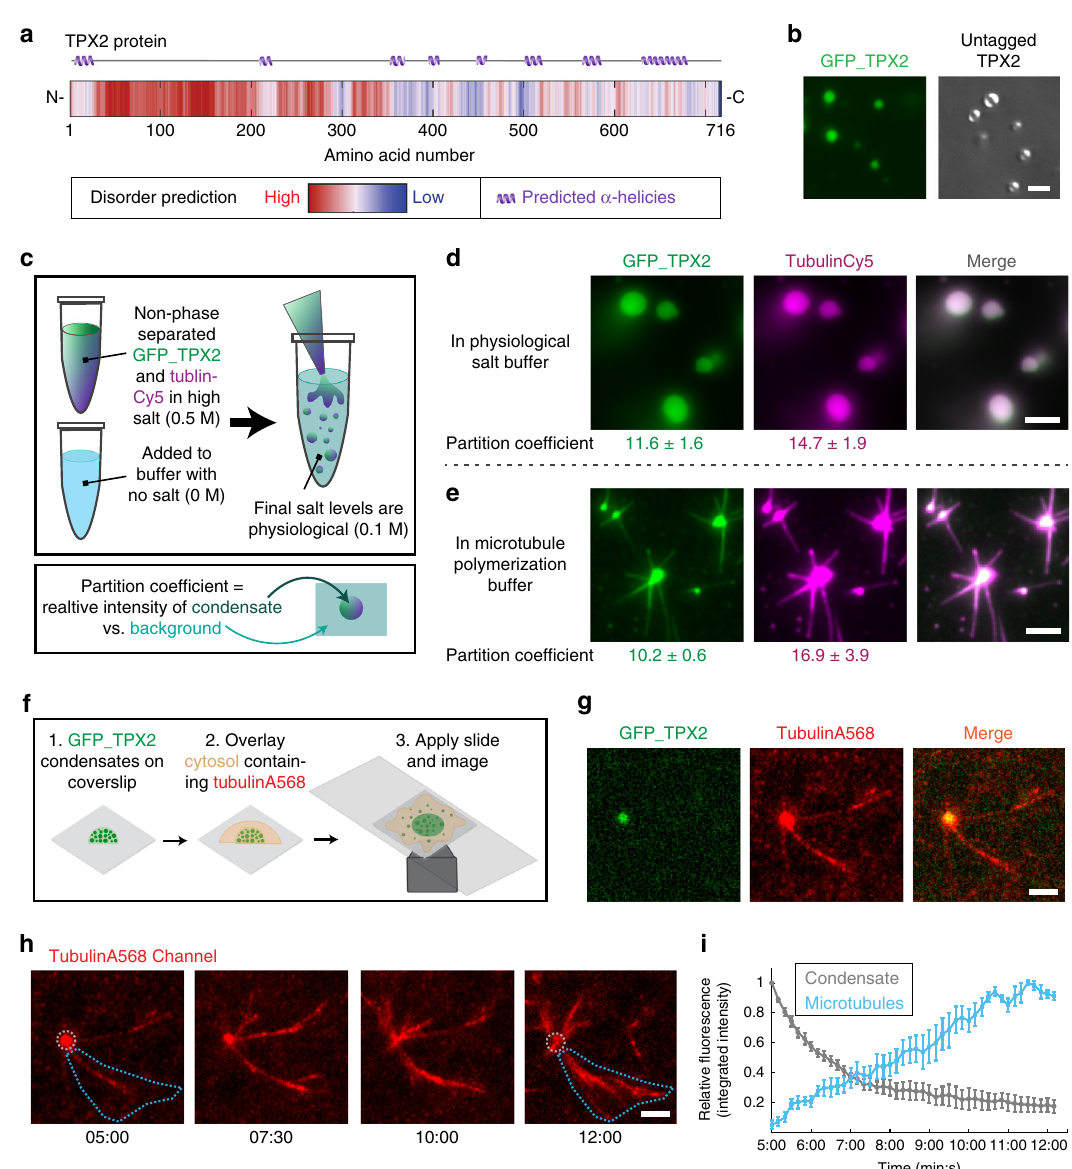
Fig. 1 TPX2 forms a co-condensate with tubulin in vitro and in the cytosol. All scale bars are 3 μ m. a Secondary structure and intrinsic disorder predictions in TPX2. b Epi fl uorescent image of GFP-TPX2 (green) condensates (see Supplementary Movie 1) (left) and DIC image of untagged TPX2 condensates (right), both at a fi nal concentration of 1 µ M. Representative of six experimental replicates. c Schematic for assaying phase separation — TPX2 (with or without other proteins) is puri fi ed and maintained in a high-salt (0.5 M) buffer and this is transferred at 1:4 volume:volume into a no salt buffer to achieve physiological salt levels (0.1 M). d Epi fl uorescent image of GFP-TPX2 (green) condensates prepared with Cy5-labeled tubulin (magenta) (both at 4 µ M) prepared as shown in c and imaged in a fl ow chamber (see Supplementary Fig. 1d for control). Representative of six experimental replicates. e TIRF image of TPX2-Tubulin co-condensates (green and magenta, 1 and 10 µ M, respectively) prepared in MT polymerization buffer in a fl ow chamber, 18 min after reaction started. Representative of three experimental replicates. Partition coef fi cients for d and e are mean values (points) with ± 1 SD as error bars from 225 and 170 condensates, respectively. f Experimental setup for g — pre-formed TPX2 condensates are overlaid with Xenopus egg cytosol containing fl uorescent tubulin. g Oblique-TIRF microscopy of GFP-TPX2 (green) and tubulin (Alexa568-labeled — red) taken 5 min after reaction started (minutes: seconds). h In the same experiment as shown in Fig. 1g, the tubulin channel imaged over time (minutes:seconds) and depicted. Data representative of three experimental replicates. i Quanti fi cation of integrated tubulin signal from indicated areas corresponding to initial condensates (gray) and MT fan structures (blue). Mean values shown as circles with ± 1 SD shown as error bars from n = 5 technical replicates. Source data are provided as a Source Data fi